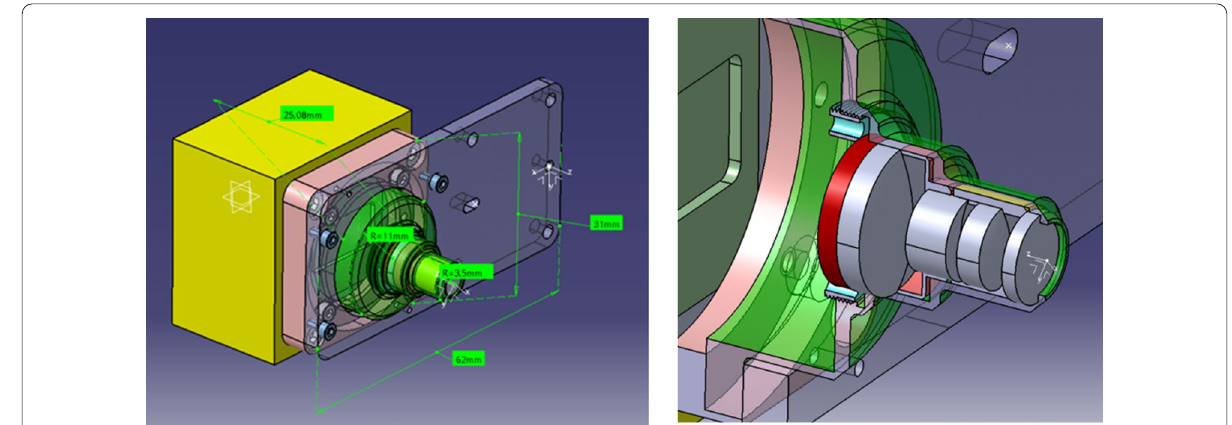
Fig. 7 The wheel cameras (WheelCams) in their pre-phase A design. Left: CAD view; right: schematic